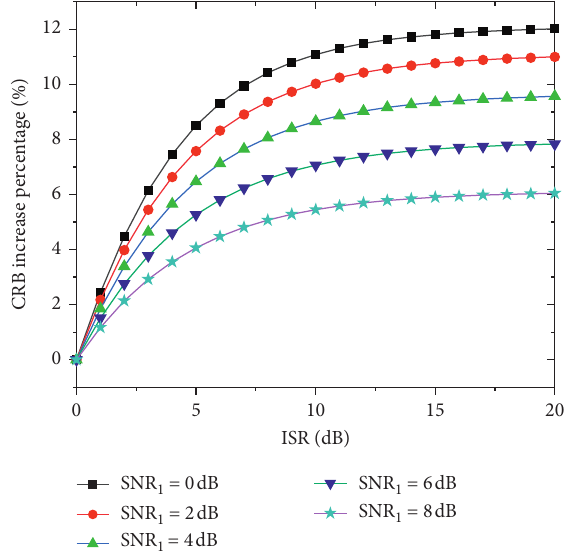
Figure 3: The CRB increase percentages for the weak source against the ISR under different SNR 1